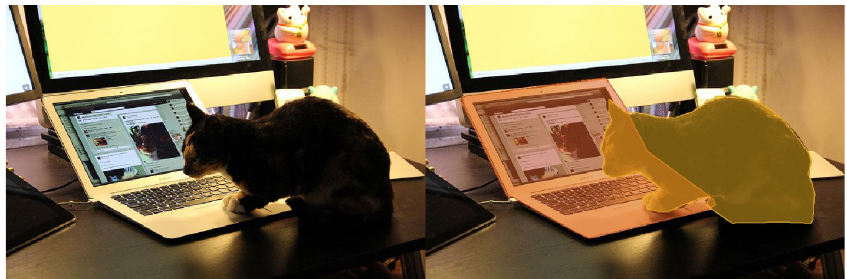
Figure 1. Humans have powerful amodal perception capabilities, just like when seeing the occluded scene in the picture on the left: a cat lying prone in front of the laptop. You can still perceive the complete shape of the laptop, as shown on the